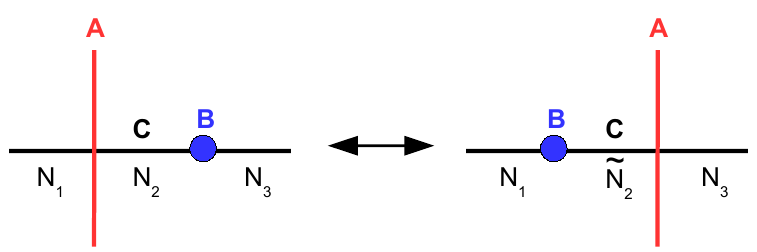
Figure 3 . Hanany-Witten brane creation e(cid:11)ect. The triplet of branes ( A; B; C ) can be either ( D 5 ; NS 5 ; D 3), or ( D 3 0 ; D 5 ; F 1), or ( D 3 00 ; NS 5 ; D 1). As the A and B branes pass across each other the number of C branes stretched between them goes from N 2 to e N 2 = N 1 + N 3 (cid:0) N 2 +